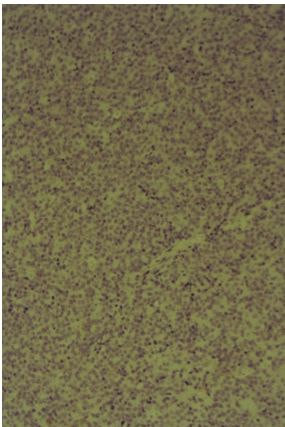
Figure 4: Lymph node biopsy immunohistochemical staining showing negative CD10 expression.